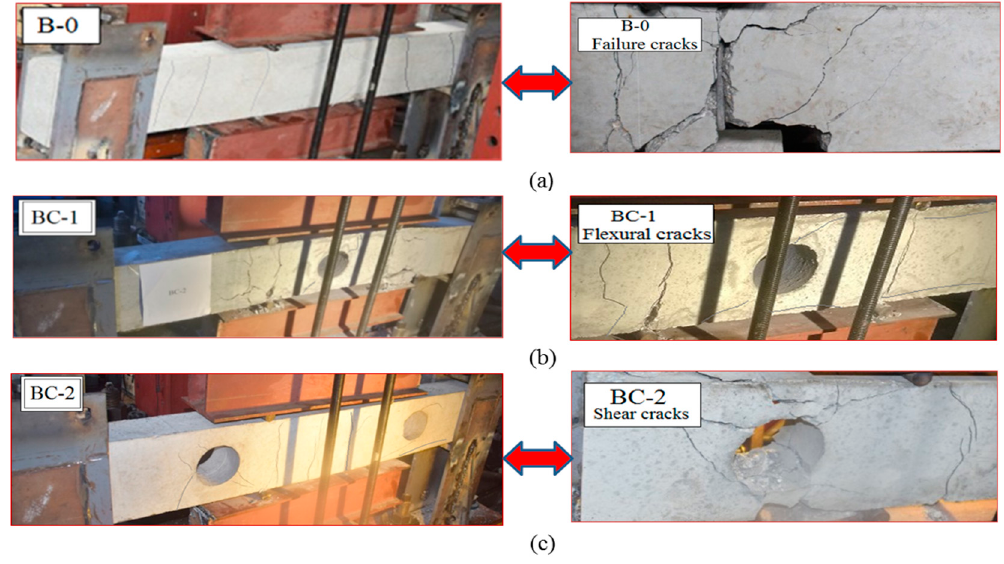
Figure 5. Observed failure mode for unstrengthen beams: ( a ) solid beam B-0, ( b ) BC-1, ( c ) BC-2.